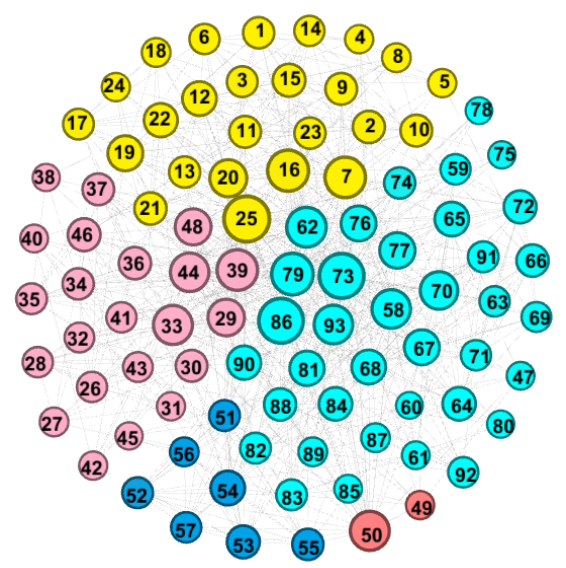
Figure 1. Topology of the female sex worker (FSW) social network.